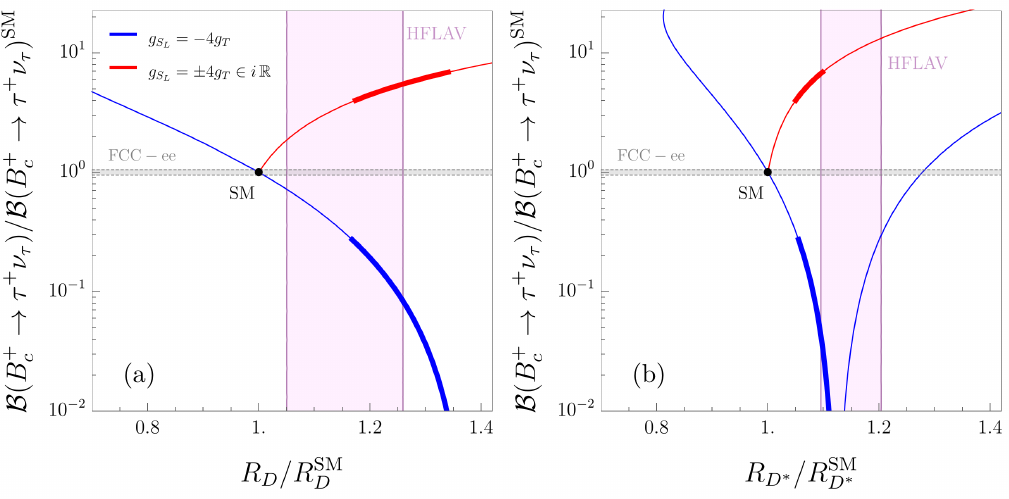
and (b) R are plotted against the ratio SM D ∗ /R D D ∗ = − 4 g (blue) and (ii) T L data [72]. The magenta shaded τ and R from HFLAV at 1 σ accuracy [23]. D D ∗ → τ + ν τ ) / | V cb | 2 c